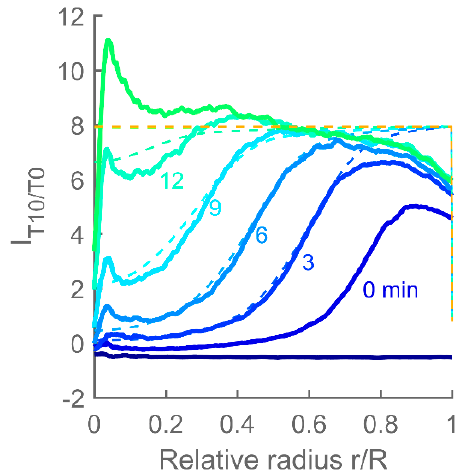
Figure 9. Spatiotemporal evolution of relative target (carboxyfluorescein-labelled MO- T10 ) concentration I T10/T0 after exposure of an MO hydrogel to the target solution at approximately t = 0 . The depicted hydrogel is the one in Figure 7d. A profile is plotted for every third minute. In dotted lines, the profiles obtained by fitting the numerical reaction-diffusion model to the experimental data. Table 2. Parameters obtained by fitting the reaction–di ff usion model to the CLSM data for MO- T10 spatiotemporal distribution in MO